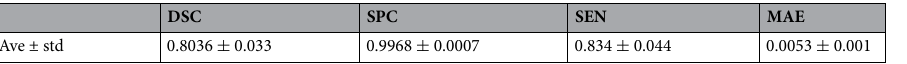
Table 1. Performance of the proposed segmentation network on the test set through 10-fold cross-validation approach.